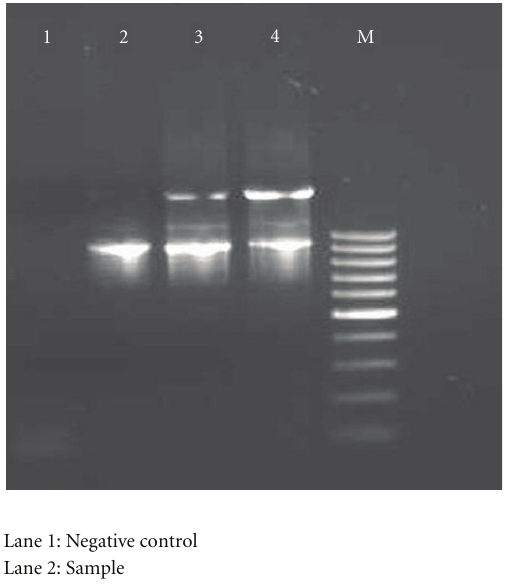
Figure 3: Results of PCR for WSSV from diseased shrimps from seasonal pond-1.